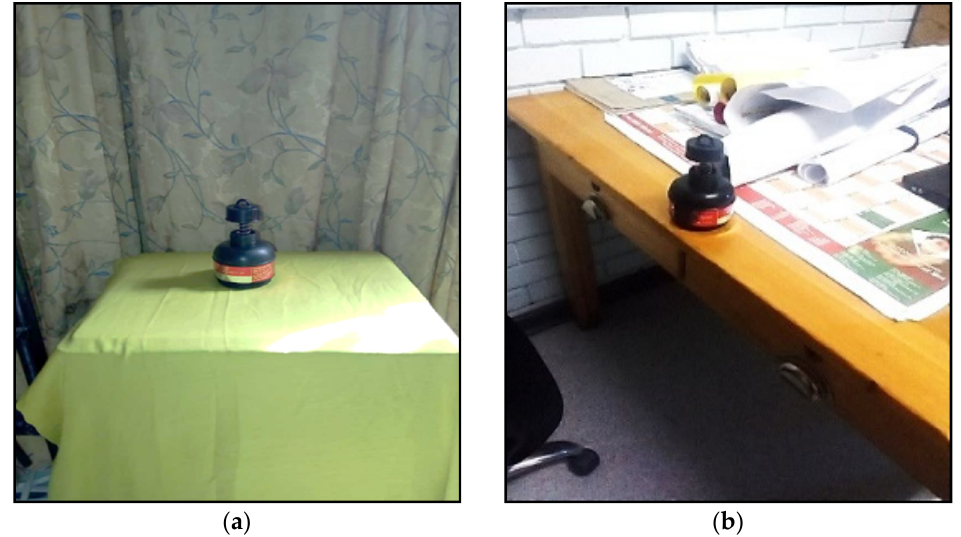
Figure 3. ( a ) Photograph of a deployed E-PERM in one of the learner’s homes and ( b ) in a school staff room.